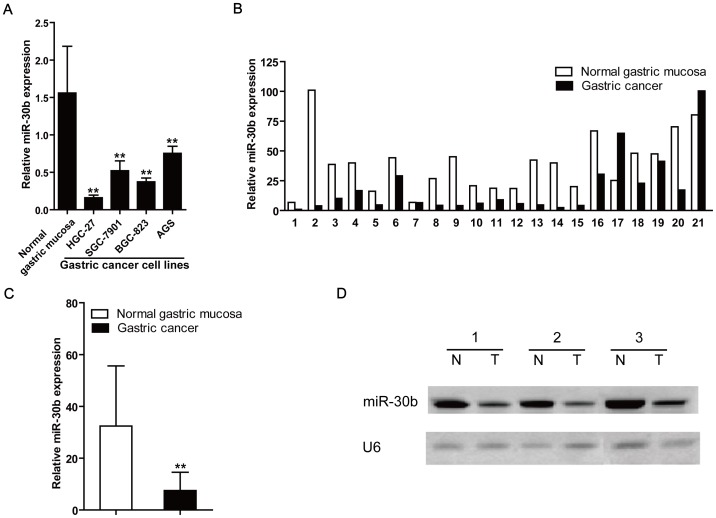
Decreased miR-30b expression in human gastric cancer cell lines and tumor tissues.(A) Comparison of expression level of miR-30b between normal gastric mucosa tissue samples and gastric cancer cell lines HGC-27, SGC-7901, BGC-823 and AGS. **P<0.01, compared with normal tissues. (B) Relative expression of miR-30b in 21 gastric cancer tissues compared with matched adjacent non-tumor gastric tissues. (C) Comparison of the average expression of miR-30b in two groups of B. Data represent means±S.D. **P<0.01, compared with normal gastric mucosa. (D) Analysis of miR-30b expression by using Northern blotting. Total RNA was extracted from three paired gastric cancer (T) and adjacent non-cancerous gastric tissues (N), which were randomly chosen from all patients. RNAs were hybridized sequentially with miR-30b and U6 probe, and U6 was used as a control for RNA loading.